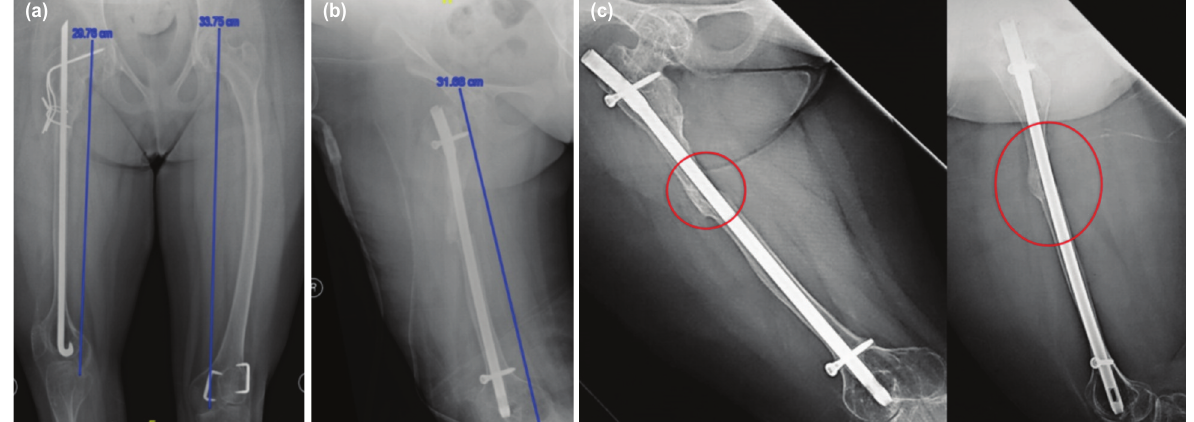
(a) Pre-operative radiograph with estimated 4cm shortening and malrotation, evidence by the overlapping distal femoral Fig. 1: condyles in anteroposterior view. (b) Post-operative radiographs with bone gap of 2cm filled with iliac bone cortical graft. (c) Post-operative AP and Lateral radiograph showing well incorporated bone graft.